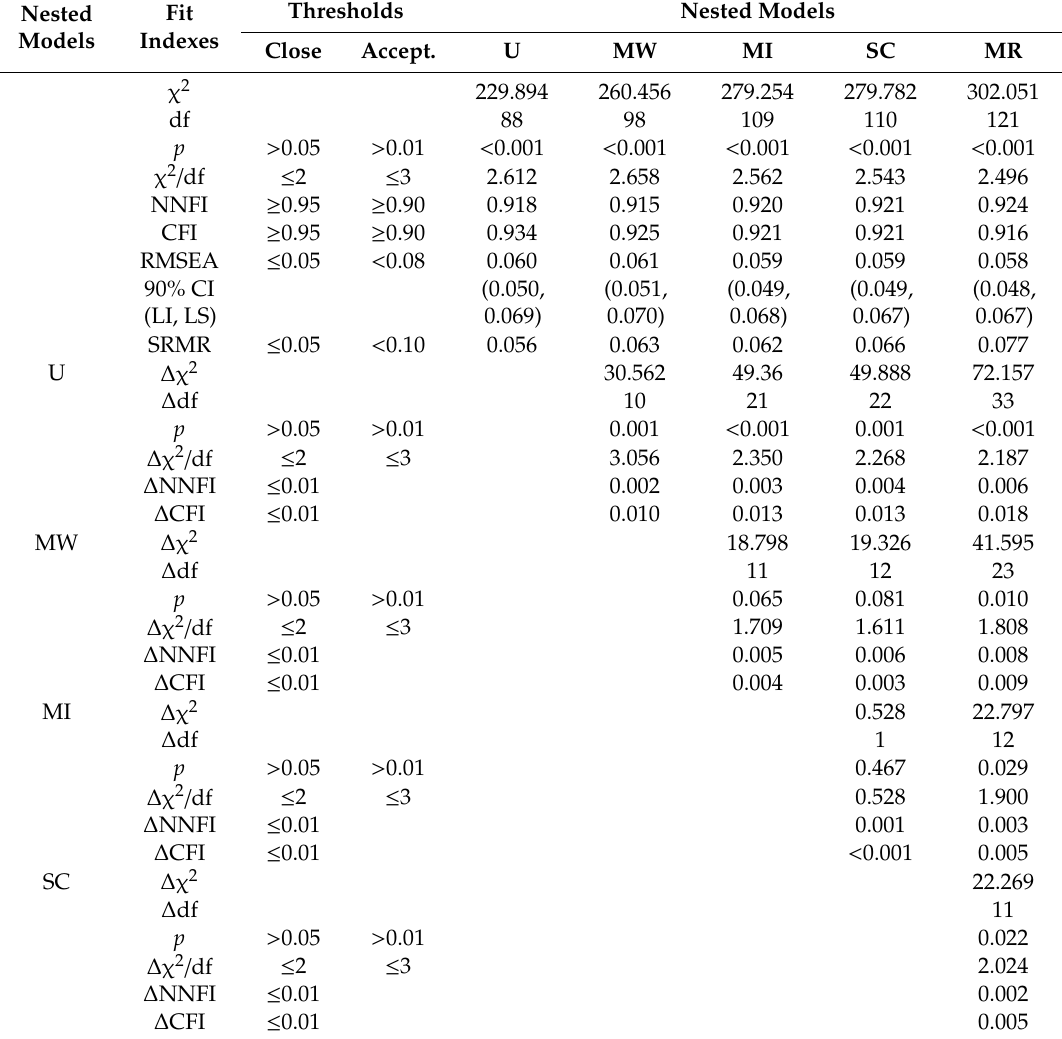
Table 5. Measurement invariance across two subsamples for the single-factor model with 11 indicators and independent